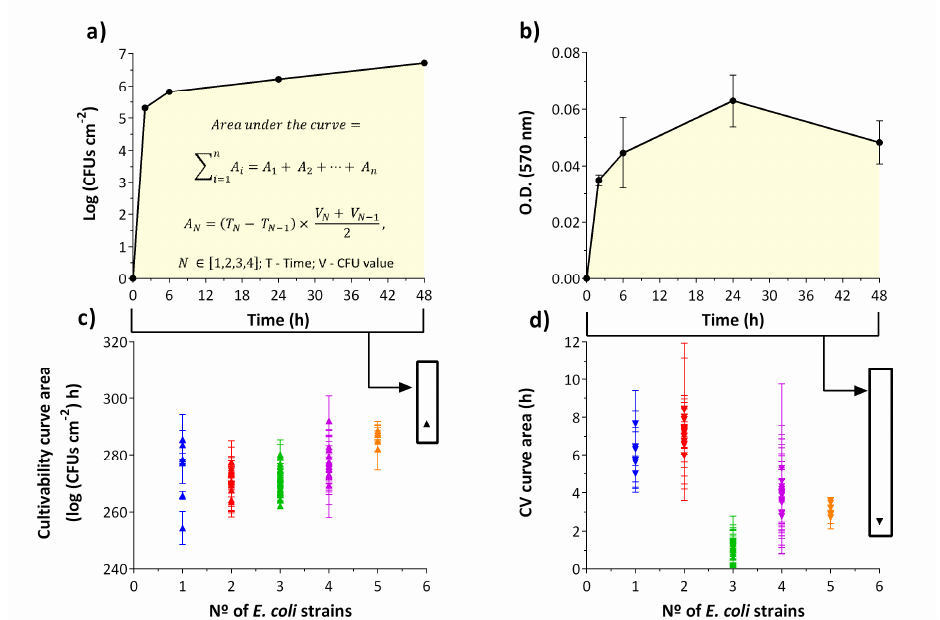
Figure 1. Biofilm formation profiles exhibited by the combination of Escherichia coli strains during 48 h, at 37 °C in AUM (artificial urine medium). Example of calculation of the area under the curve for cultivability ( a ) and total biomass ( b ). Cultivability areas showing a relationship between the number of cultivable cells and the number of strains within the biofilm ( c ). CV (crystal violet) areas show a trend of biomass reduction as the number of different strains within the biofilm increases ( d ). The results represent three independent experiments. Results are presented as the mean ± standard deviation. A—partial area; T—time; V—Log (CFUs·cm − 2 ) value or O.D.620 nm value.